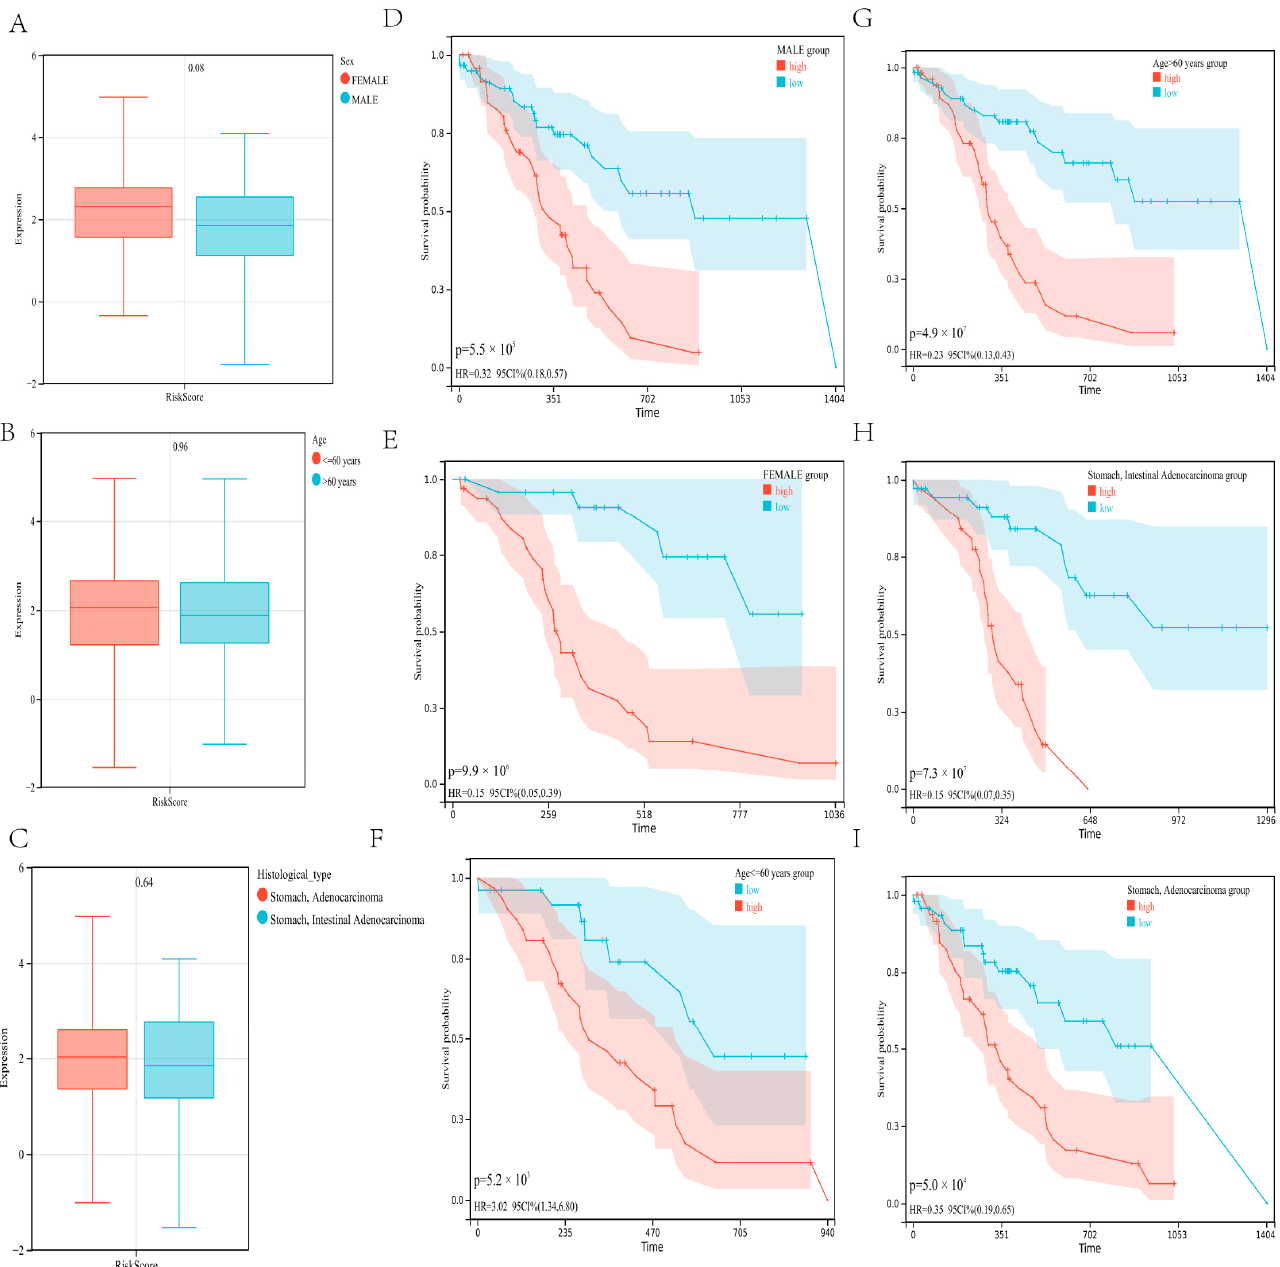
Figure 6. Correlation between risk score and clinical characteristics ( A – C ). No significant difference was determined in patients with different genders ( A ), ages ( B ), and histological types ( C ). Independence analysis of the risk model ( D – I ). The survival curve was regrouped by genders ( D , E ), ages ( F , G ), and histological types ( H , I ).